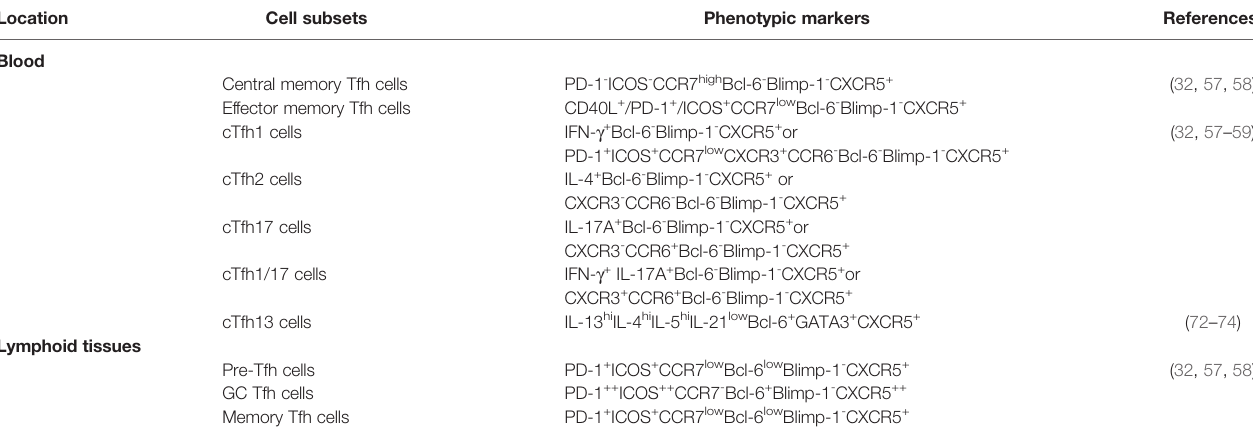
TABLE 1 | Phenotypes of Tfh cell subsets in blood and lymphoid tissues.